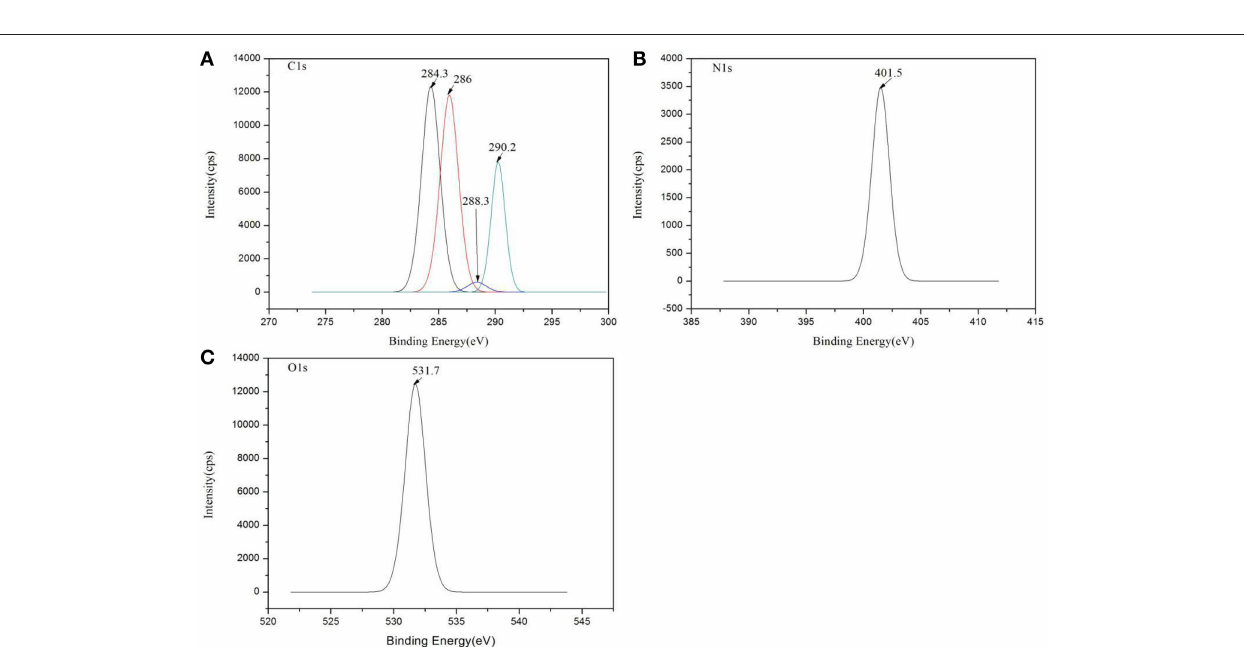
FIGURE 6 | X-ray photoelectron spectrum of the C1s (A) , N1s (B) , and O1s (C) for PVDF/IL/CNTs.